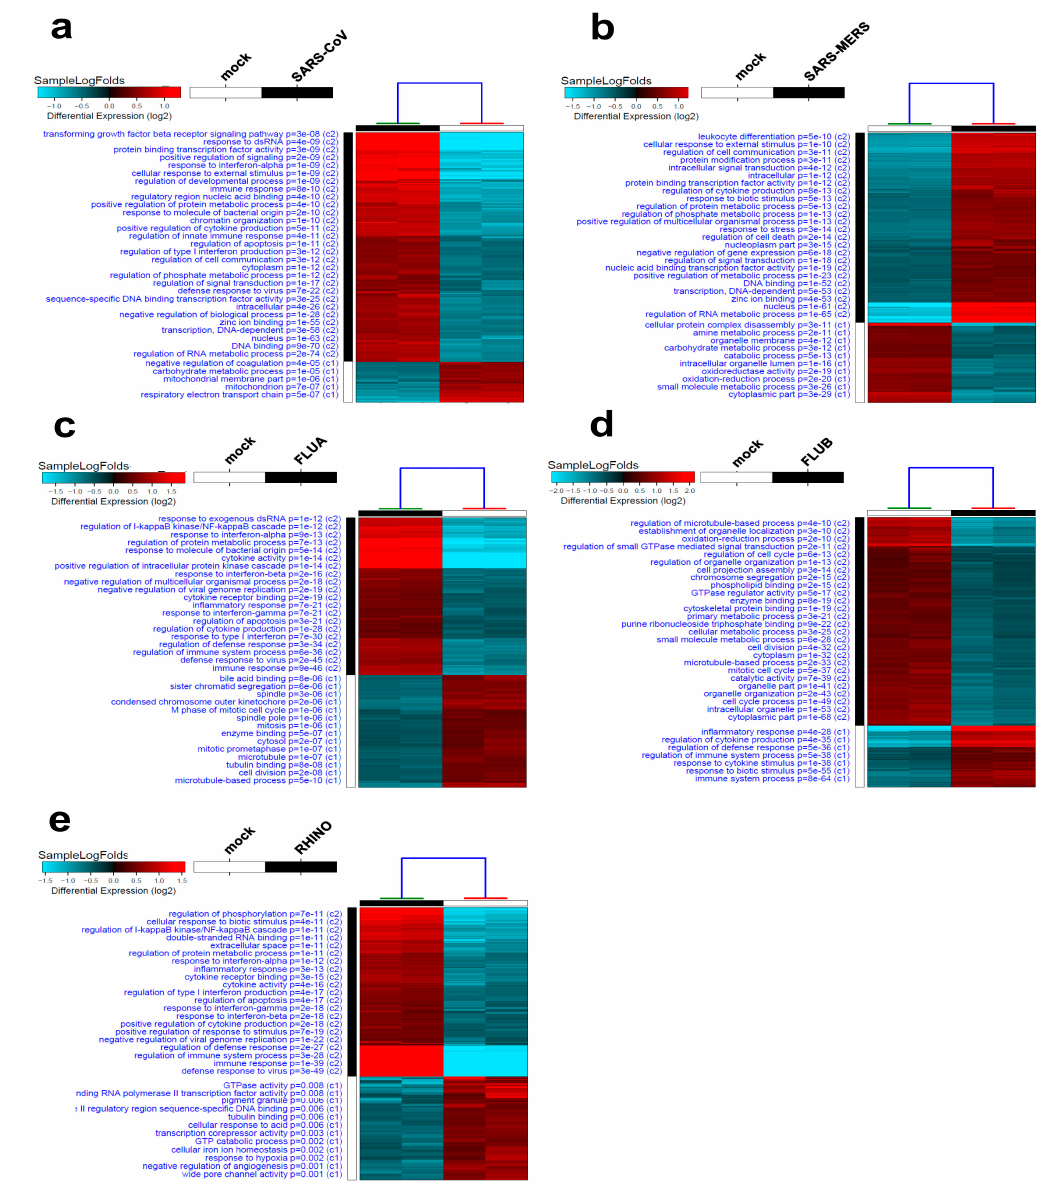
Figure 2. Hierarchical clustering and gene ontology (GO) enrichment of Calu-3 cells infected with different viruses. SARS-CoV ( a ), SARS-MERS ( b ), influenzavirus A (FLUA) ( c ), influenzavirus B (FLUB) ( d ), and rhinovirus (RHINO) ( e ). Affected gene ontology (GO) category in each experimental group is indicated on the left side. Each column represents one replica and each row represents a single gene. The expression level for each gene is depicted according to the color scale. MERS: Middle East respiratory syndrome.